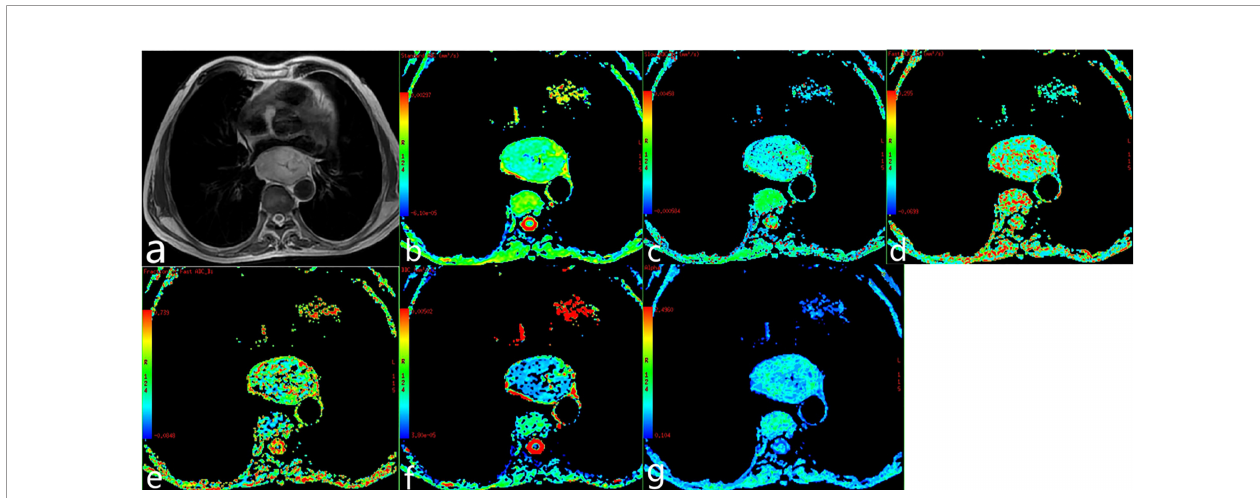
FIGURE 3 | Poorlydifferentiatedesophagealcarcinomaofa62-year-oldman. (A) T2-weightedimage. (B – G) ADCmap,ADC slow map,ADC fast map, f map,DDCmap,and a